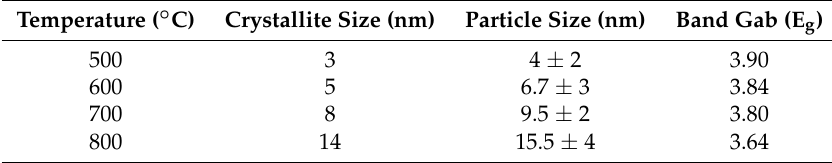
Table 1. XRD, TEM and energy band gap results for tin oxide nanoparticles at different